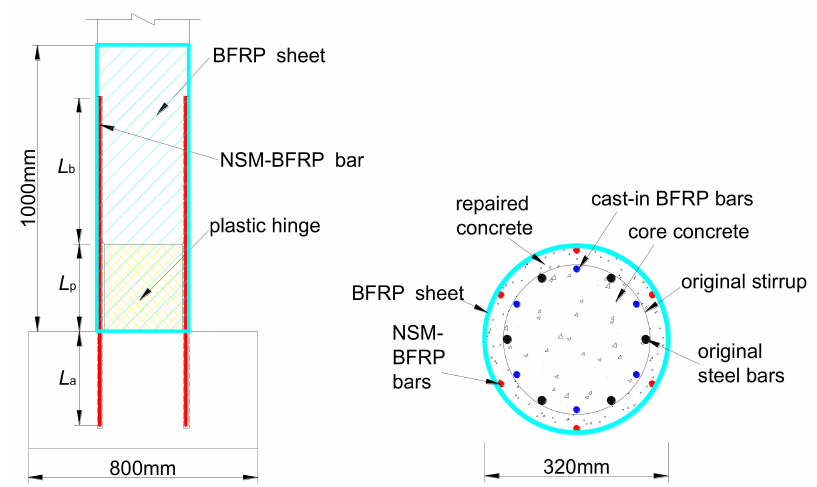
Figure 7. Repair techniques for the damaged specimens.